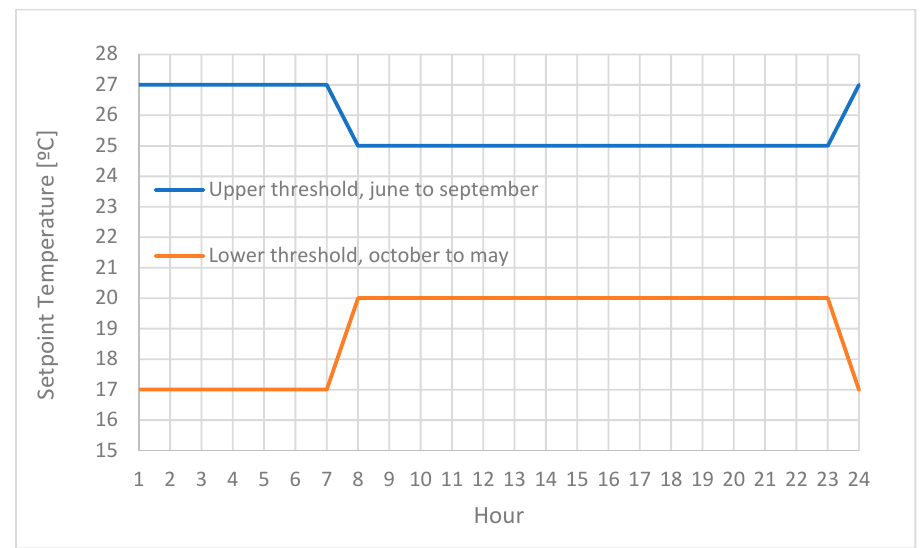
Figure 2. Operation patterns of the conditioning systems and their set point temperatures.